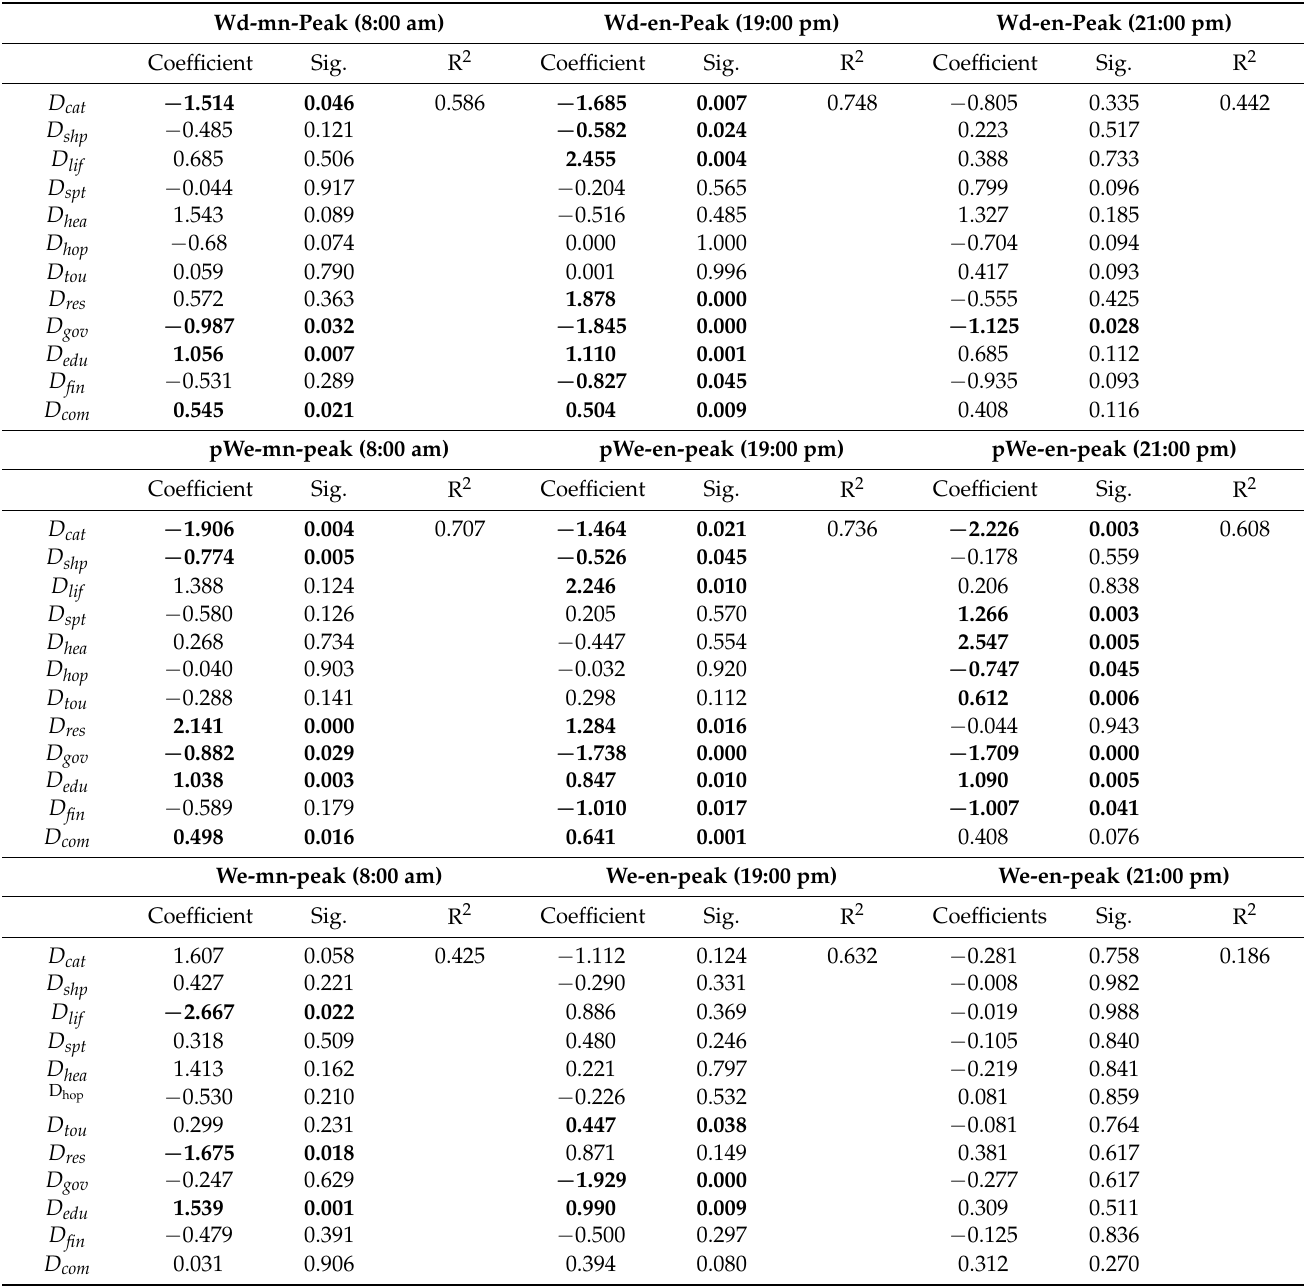
Table 2. Regression results of traffic congestion in weekday